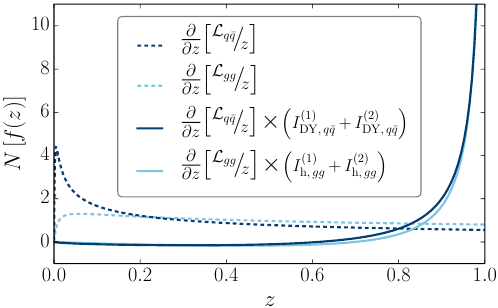
Figure 3. The derivative of the parton luminosity (dashed) and its point-by-point multiplication with the integrated LP partonic coefficient function up to NNLO (solid), for both DY (dark blue) and single Higgs (light blue) production at Q = µ = 125 GeV. All curves are normalized according to eq.